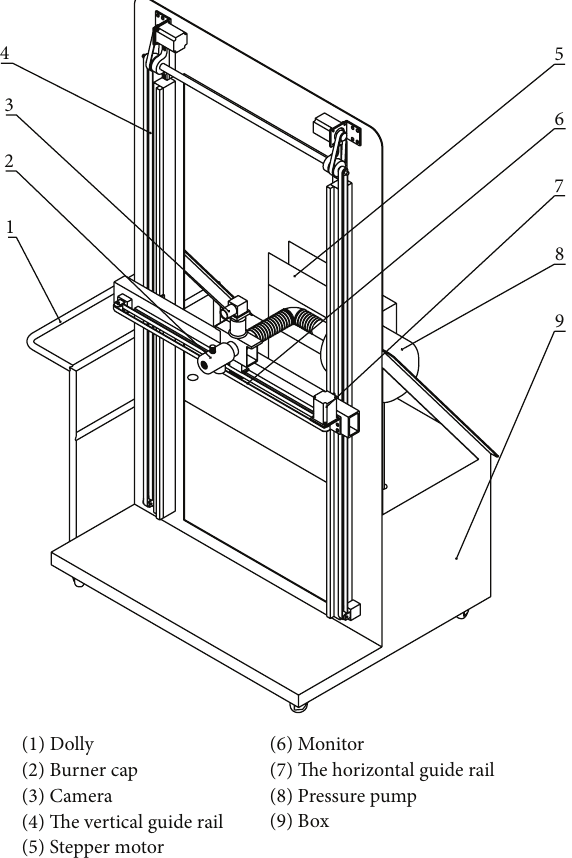
Figure 2: Sketch map of the overall structure of the system.